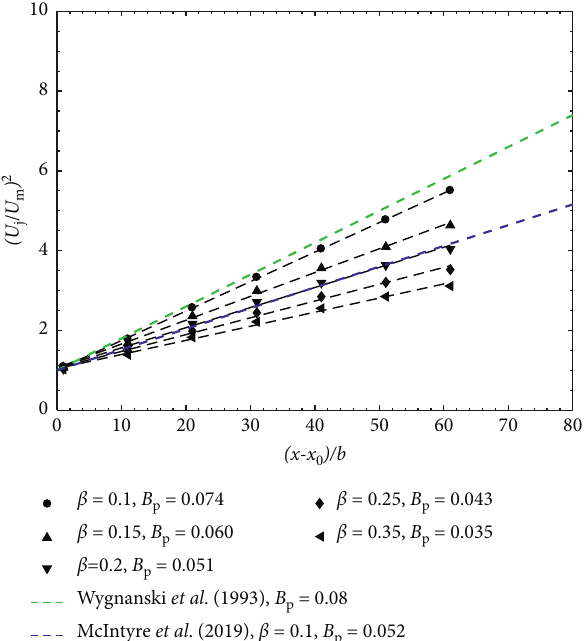
m for various velocity ratios.